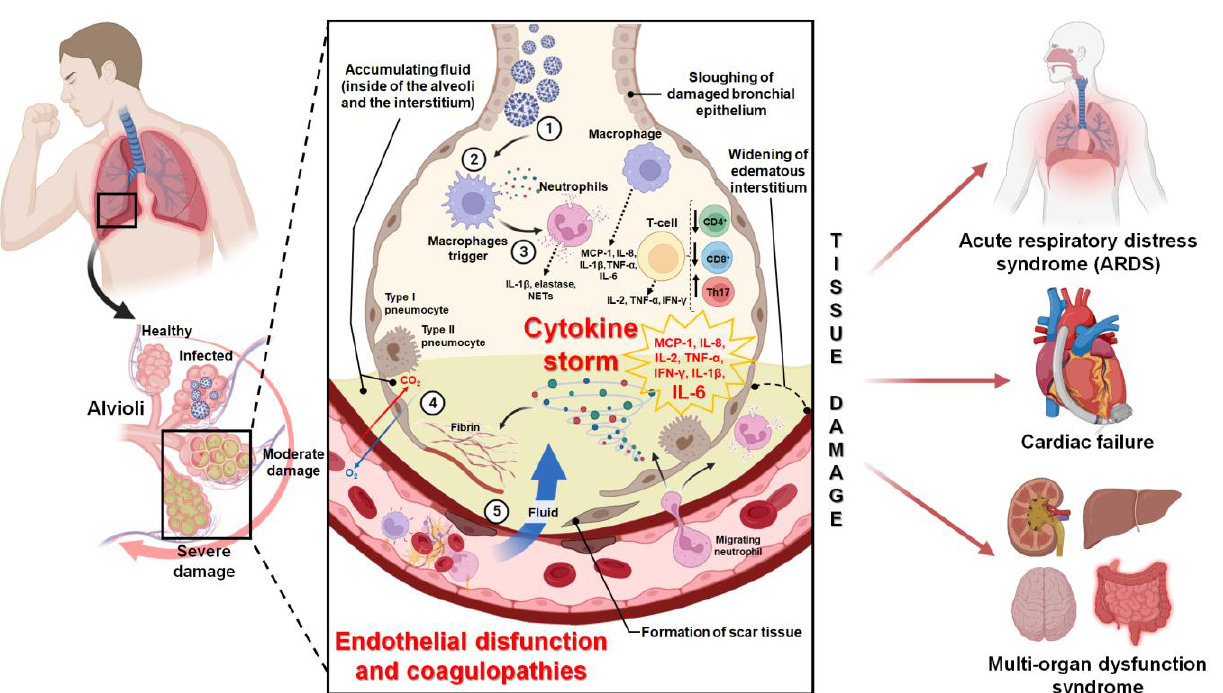
Figure 3. The pathophysiological mechanism of COVID-19 related to clinical complications, such as cytokine storm and thromboembolic coagulopathies. According to Ortega-Paz et al. [68] and Bhaskar et al. [69] the pathophysiological mechanism is characterized by: ( 1 ) The viral binding of SARS-CoV-2 to the ACE2 receptor present in type II pneumocytes and vascular endothelial cells of the pulmonary alveoli; ( 2 ) immune cells, including macrophages, that identify the virus, become activated and produce acute response chemokines and cytokines; ( 3 ) chemokines and cytokines that attract and activate more immune cells, in particular the activation of neutrophils, macrophages, and Th17 cells (and cause the downregulation of CD4 + and CD8 + T cells) and that causes an exacerbated increase in the production of proinflammatory cytokines, thereby creating a cycle of inflammation or a hyperinflammatory response, such as the cytokine storm. This is then characterized by a marked increase in the monocyte chemoattractant protein-1 (MCP-1), interleukin (IL)-8, IL-2, tumor necrosis factor alpha (TNF- α ), Interferon gamma (IFN- γ ), IL-1 β and in particular IL-6; ( 4 ) hyper-elevated proinflammatory cytokines could promote and cause cell death, not only of pneumocytes, but also of the endothelial cells of adjacent blood vessels, thereby causing the release of tissue factors (TF), the exposure of subendothelial components (Von Willebrand factor (VWF) and collagen), and fibrin formation. These events stimulate endothelial dysfunction and coagulation (extrinsic and intrinsic pathways), which leads to intravascular thrombosis and, finally, to the development of thromboembolic coagulopathies; ( 5 ) weakened and damaged vascular endothelium allows protein- rich fluid to leak and fill the lung cavities (into the alveoli and alveolar interstitium), leading to the damage and death of the bronchial epithelium, formation of scar tissue, and failure of respiratory system (decreased gas exchange), which leads to different pathologies and clinical complications. These are also initially generated at the pulmonary level, but which later led to the heart and other tissues of the body causing multi-organ dysfunction syndrome and